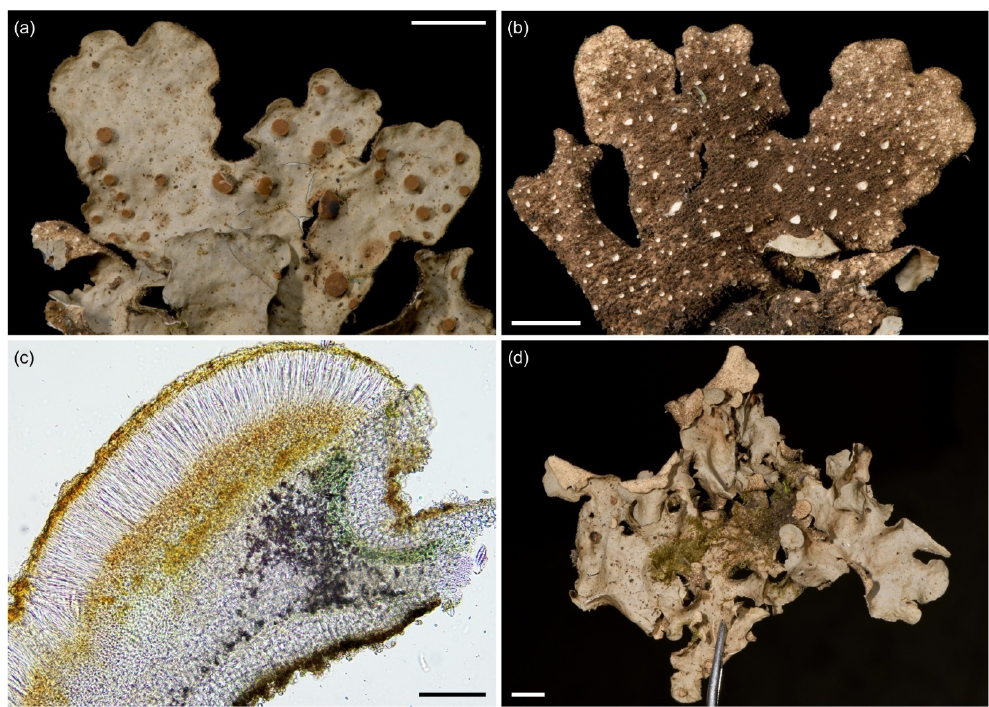
Figure 12. Sticta munda. ( a – c ) Type specimen UK171584u. ( a , b ) Typical single lobed, palmate, and abundantly fertile specimen seen from the upper and lower side. ( c ) A cross section of apothecium. ( d ) Specimen UK171582i with a rosetteform thallus. Scales 0.5 cm in ( a , b , d ), 100 µm in ( c ).